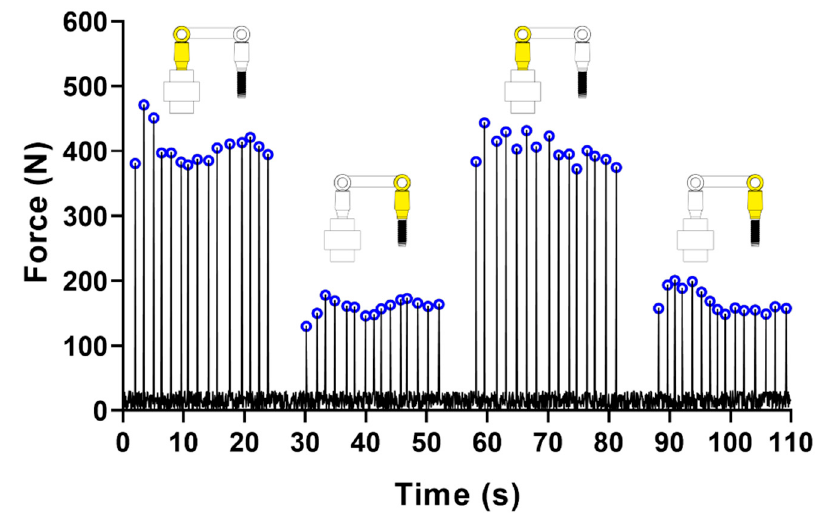
Figure 4. Representative force trend over time: detected force peaks are encircled in blue. The stressed side of the bridge during each series of impulses is highlighted in yellow. The load cell drawing was added for representative purposes, the scales of the cell and the bridge are not consistent.